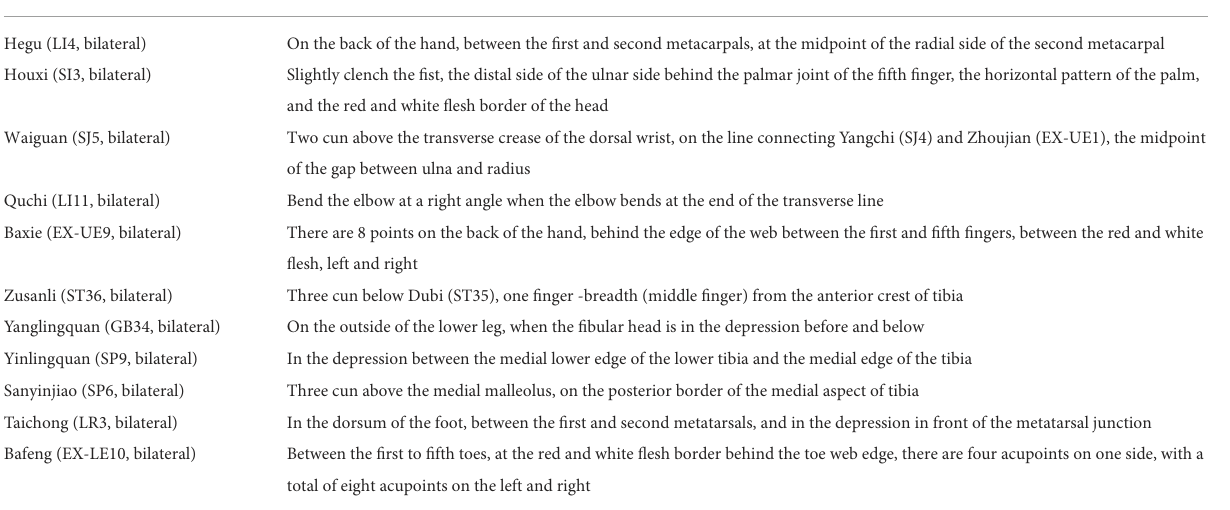
Follow- up period Week